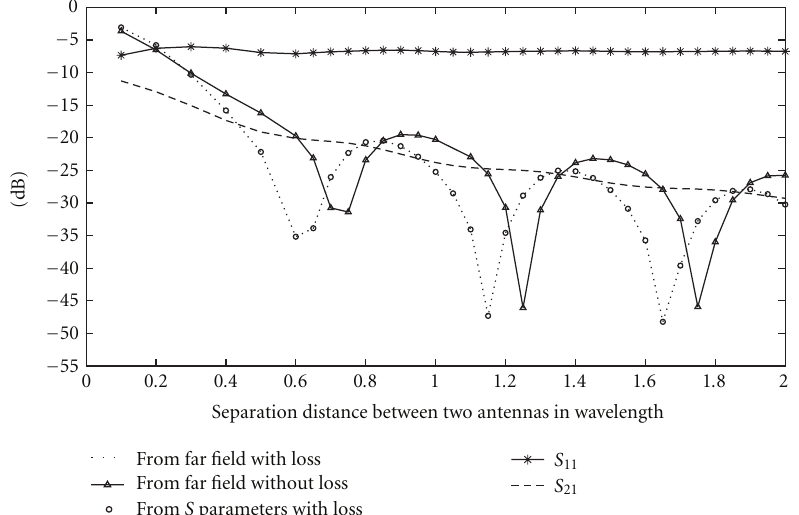
Figure 3: The computed spatial envelope correlations and scattering parameters between dipoles 1 and 2 versus their separation distance, in a MIMO system of three elements, arranged in a uniform linear array.